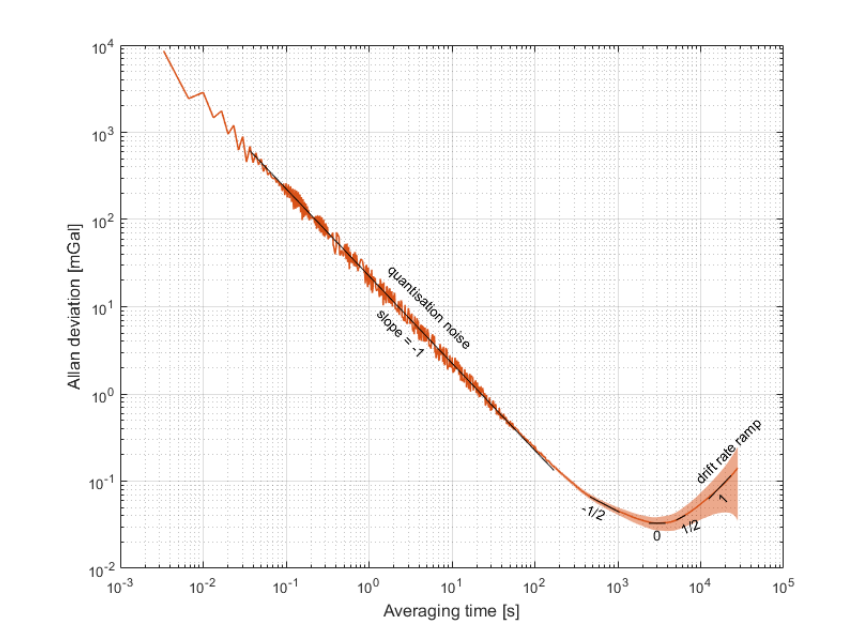
Figure 2. Allan deviation derived from the 29 h static recording. The shaded region shows the 1 σ (68%) uncertainty region. Also shown are the different regions of the curve, representing various error contributions.